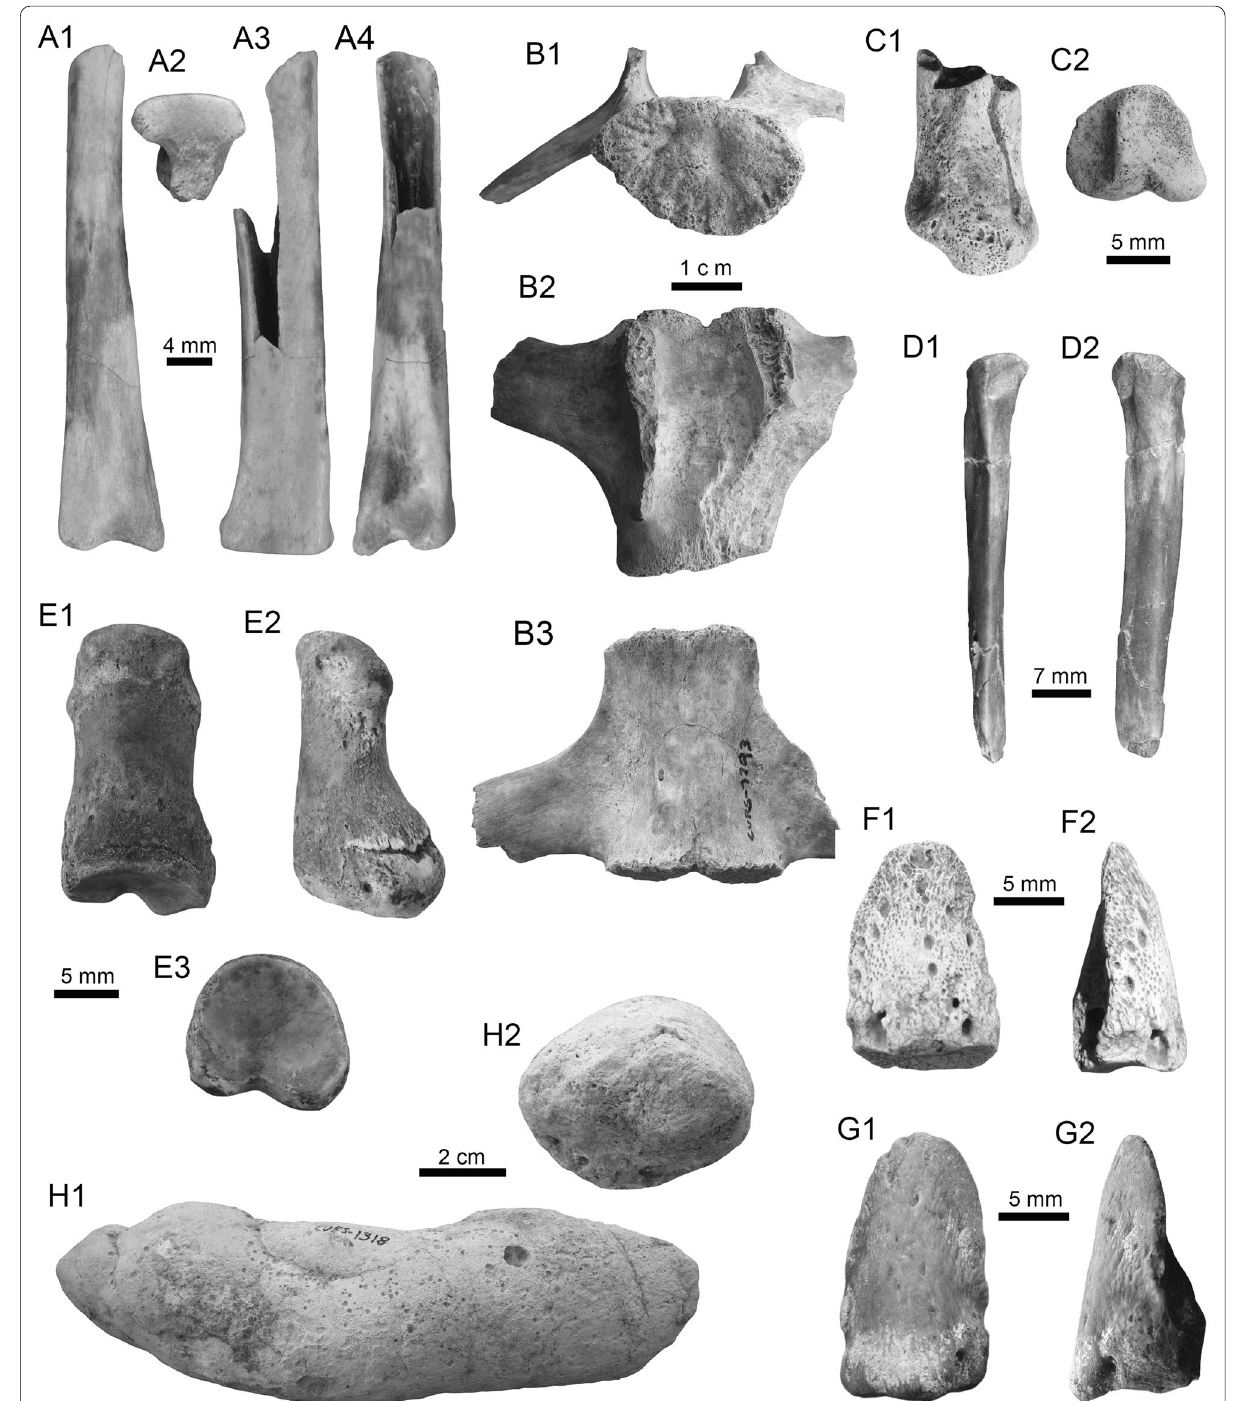
Fig. 29 Indeterminate mammalian remains and coprolites from the Norte Casa Chiguaje ( A1 – A4 , C1 – G2 ) and San Gregorio Oeste del Pueblo ( B1 – B3 , H1 , H2 ) localities. A1 – A4 3rd right metatarsal (AMU‑CURS‑1096). B1 – B3 Incomplete ?caudal vertebra (AMU‑CURS‑1293). C1 , C2 Distal portion of a tibia (AMU‑CURS‑1198). D1 , D2 ?right fibula (AMU‑CURS‑1197). E1 – E3 podial phalange (AMU‑CURS‑1124). F1 – G2 Ungual phalanges (AMU‑CURS‑1127). H1 , H2 Presumed crocodylian coprolite (AMU‑CURS‑1318). Views: anterior ( A3 , B1 , C1 , D1 ), cross sectional ( H2 ), dorsal ( B2 , E1 , F1 , G1 ), distal ( C2 ), lateral ( A1 , E2 , G2 , H1 ), medial ( A4 , F2 ), right lateral ( D2 ), proximal ( A2 , E3 ), and ventral ( B3